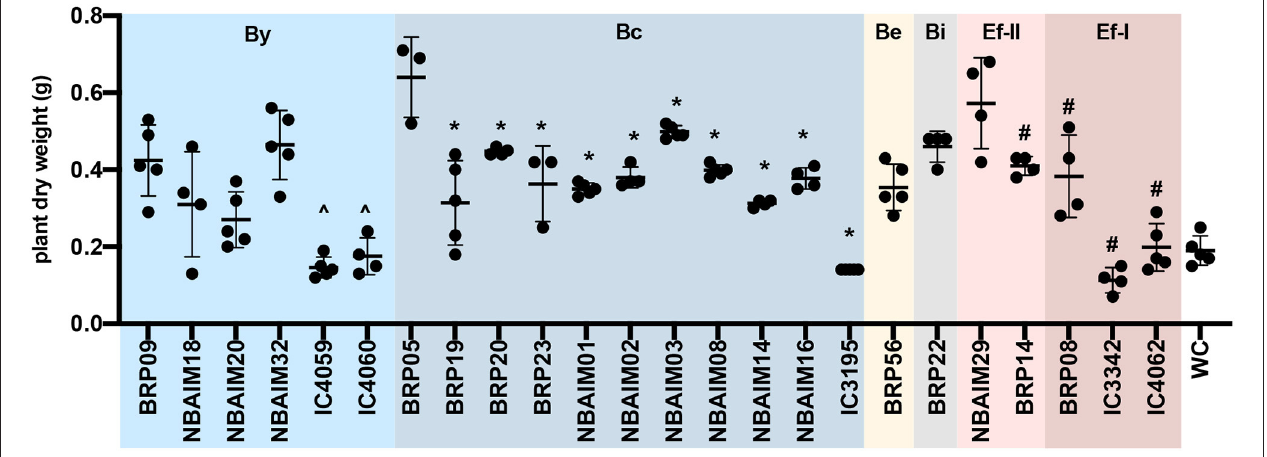
FIGURE 3 | The dry weight of plants inoculated with IU and IC strains. Each dot represents a biological replicate. ∧ Represents significant differences for each strain vs. BRP09 within the By group. *Represents significant differences for each strain vs. BRP05 within the Bc group. # Represents significant differences for each strain vs. NBAIM29. Analysis was performed using one-way ANOVA ( F = 17.51, R 2 = 0.8318, p < 0.0001), with Sidak’s post-hoc test. WC, water control.